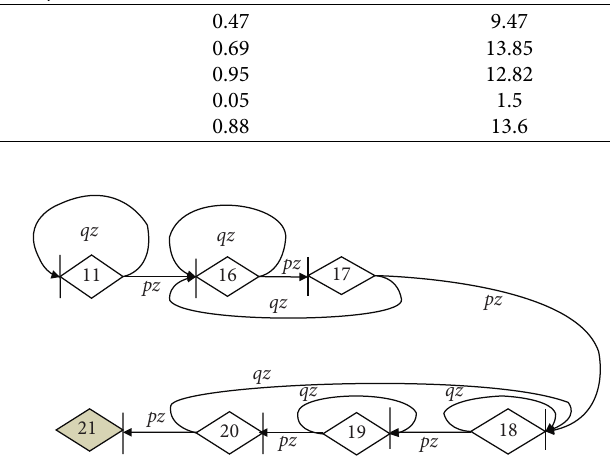
Table 3: Active calculated values of the GERT network parameter Activity